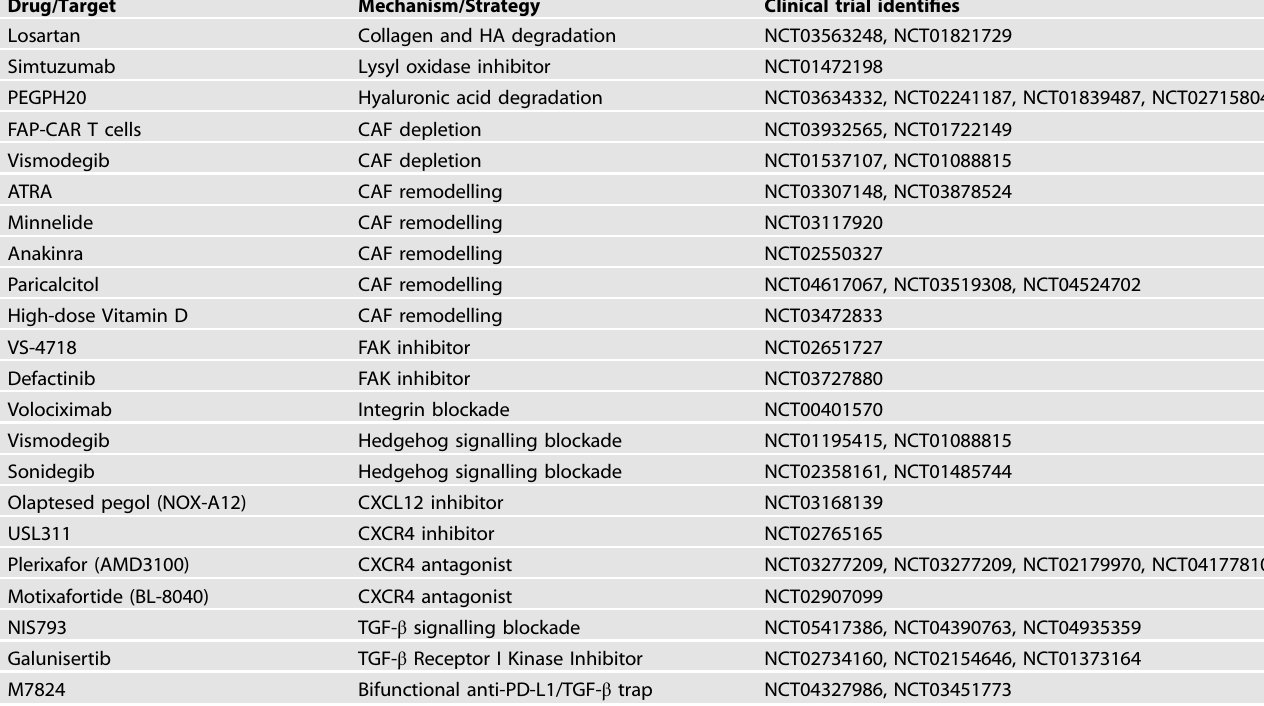
Table 3. Clinical trials targeting/relating the CAF in